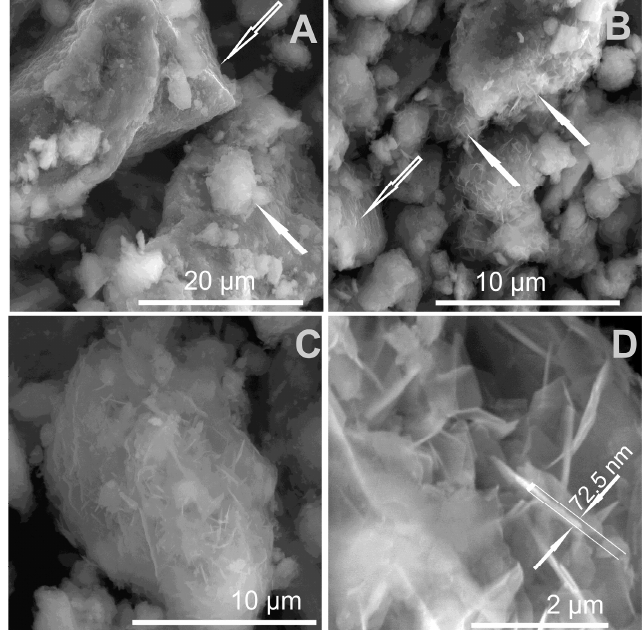
Figure 9. XRD patterns of the LDH-C material after adsorption in multi-element wastewaters.